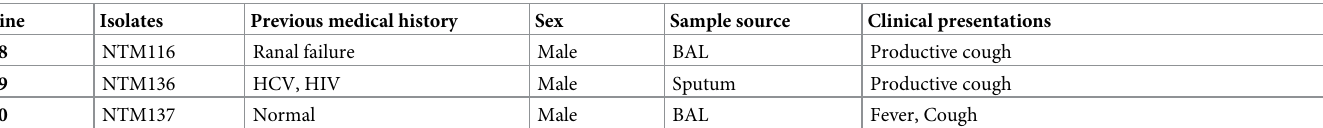
Jencons Scientific Inc, Cambridge, UK) [18]. The PCR products were sequenced using the ABI PRISM 7500 Sequence Detection System (Applied Biosystems, Foster City, CA, United States). BLAST was used to verify the rpoB gene sequences for each isolate. The sequences of the rpoB gene for each isolate were aligned separately and compared with all existing relevant sequences of mycobacteria recovered from the GenBank database using the MEGAX program. Percent- ages of similarity between sequences of each gene were determined by comparing sequences to an in-house database of rpoB sequences. Phylogenetic trees were obtained from DNA sequences using the Neighbor-Joining (NJ) method and Kimura’s two-parameter (K2P) dis- tance correction model with 1000 bootstrap replications supported by the MEGAX software (http://www.megasoftware.net) [19].